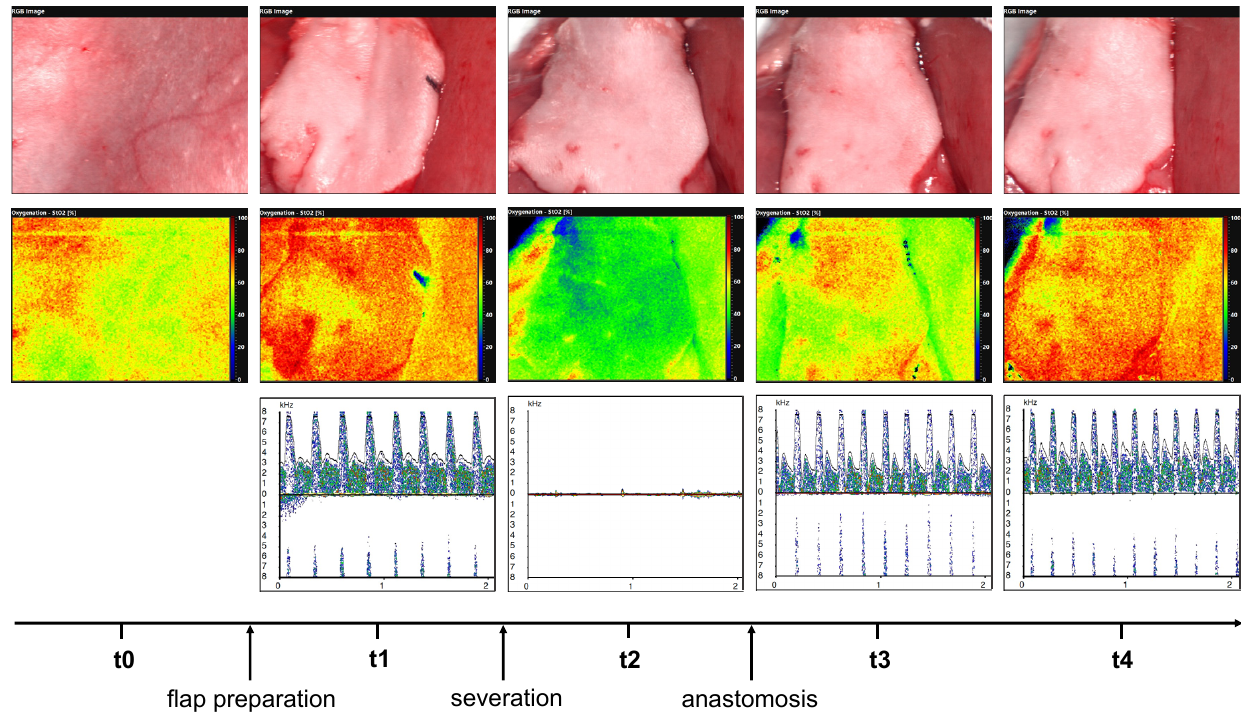
Figure 2. Illustrates hyperspectral analysis at time points t0, t1, t2, t3, and t4 (middle row) and micro-Doppler analysis at time points t1, t2, t3, and t4 (lower row). The respective clinical pictures are shown in the upper row.